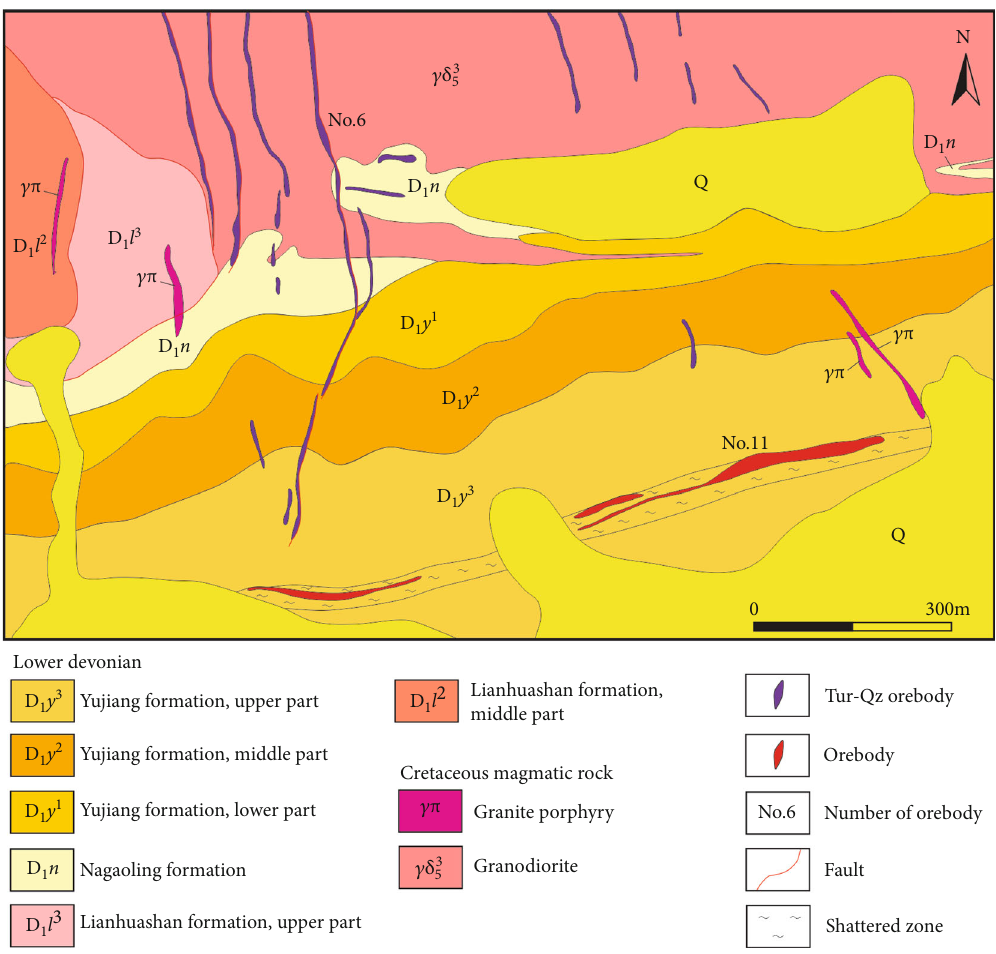
Figure 3: Geological map of the Xinmin polymetallic